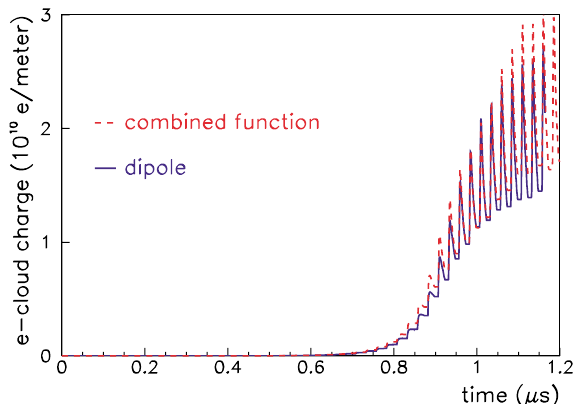
FIG. 4. (Color) Electron cloud buildup in a PS main magnet during the first 1 : 2 (cid:16) s of the bunch train with and without the field-gradient component. An rms bunch length of 2.5 ns has been considered with elastic reflection of the electrons. Both simulations were performed using a Runge-Kutta integration of the electron motion and included cyclotron oscillations in the magnetic field.